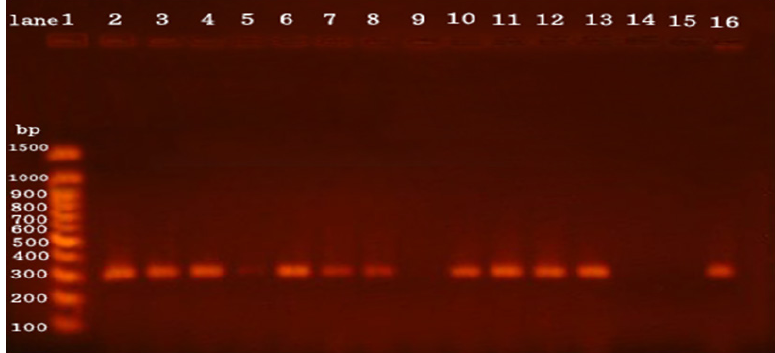
Fig. 4. Gel electrophoresis shows MecA gene fragments